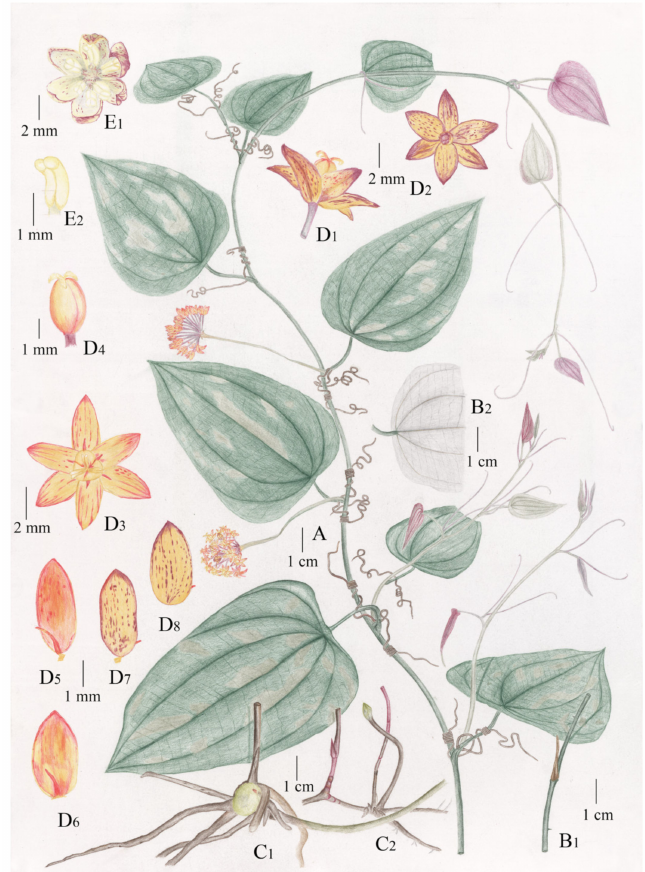
Figure 3. Illustration of Smilax weniae P. Li, Z.C. Qi & Yan Liu, sp. nov. (A) Flowering plant ( Stem, with prickles occasionally; (B2) Leaf in abaxial view; (C1) Rhizome; (C2) Rhizome with